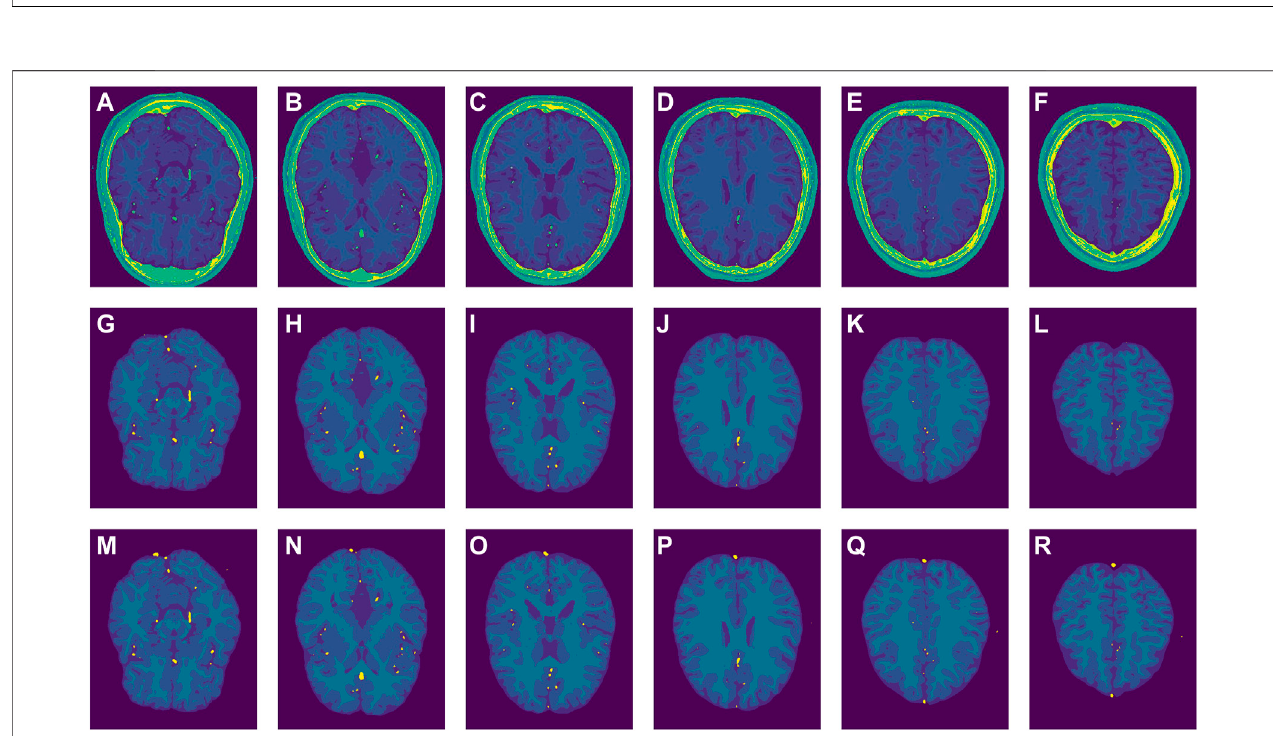
FIGURE3| Braintumorsegmentationofimagesfromthe fi rstdatasetusingminimumspanningtree. (A – H) RepresentativeaxialMRIsectionsofbrainswithtumors giving a higher intensity signal. (I – P) Segmented images (A – H) using minimum spanning tree. (Q – X) Ground truth images.